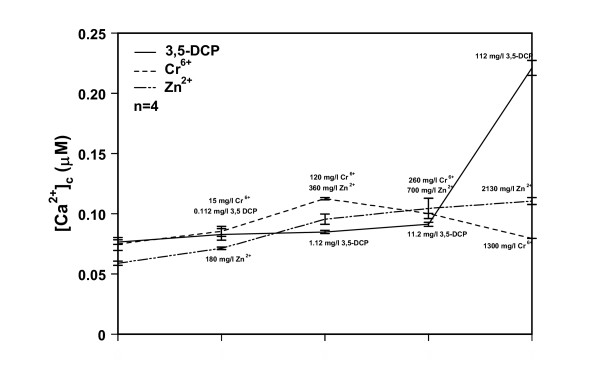
Effect of 3,5-DCP, Cr6+ and Zn2+ on final resting level of [Ca2+]c in A. awamori 5 minute incubation.